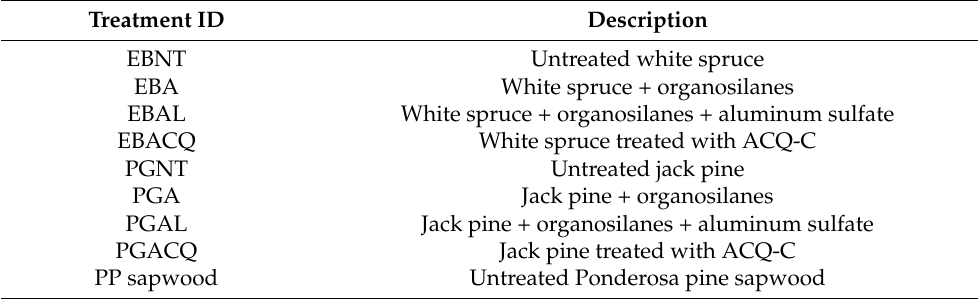
Table 3. Treatment ID and their description tested against brown rot.